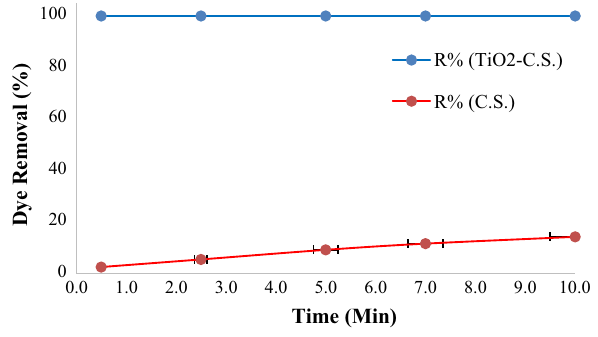
Fig. 5 Photocatalytic removal rate of RB5 50 mg L −1 concentration, 25 °C and 300 rpm